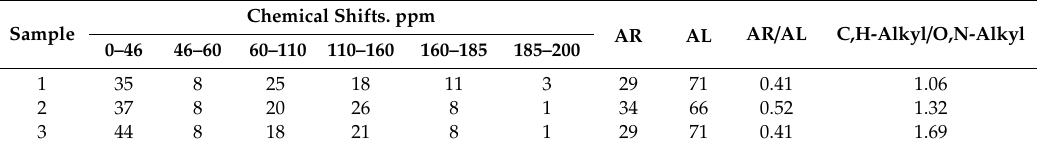
Table 6. Percentage of carbon in the main structural fragments of humic acids from the studied surface soil horizons (according to CP / MAS 13 C-NMR data). Sample numbers correspond to Table